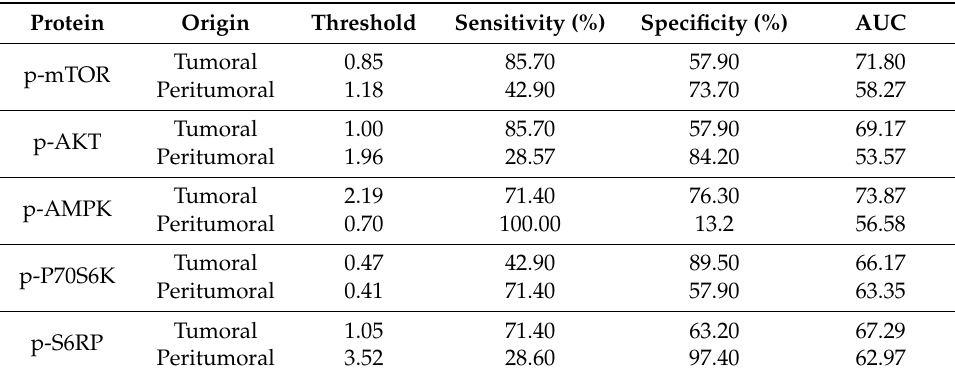
Table 3. Optimal threshold, sensitivity, specificity and area under ROC curve (AUC).